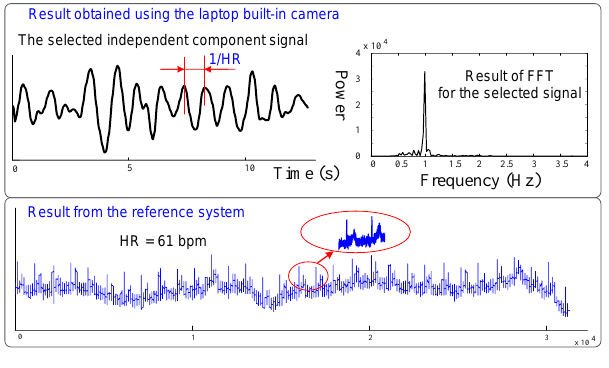
Fig 3. Obtained cardiac pulse of one participant.